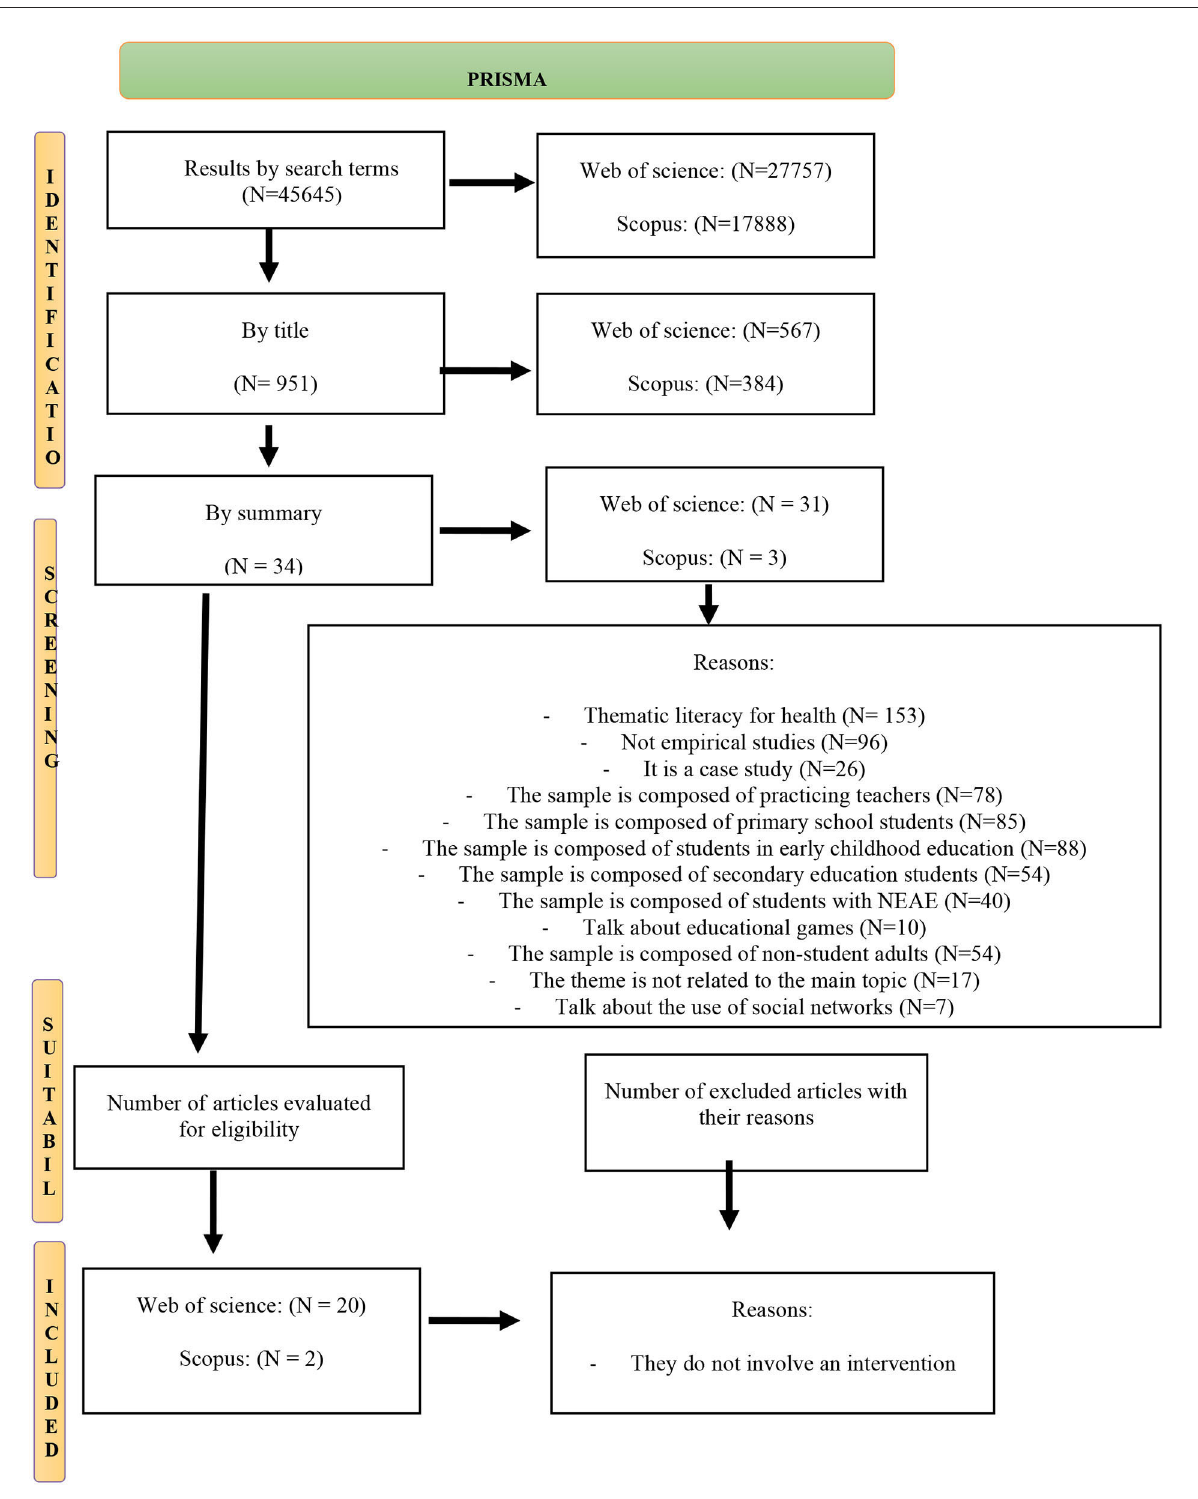
FIGURE2 Flowchart of search results of empirical studies in databases applying the criteria of Moher et al. (2009) and Page et al. (2021).